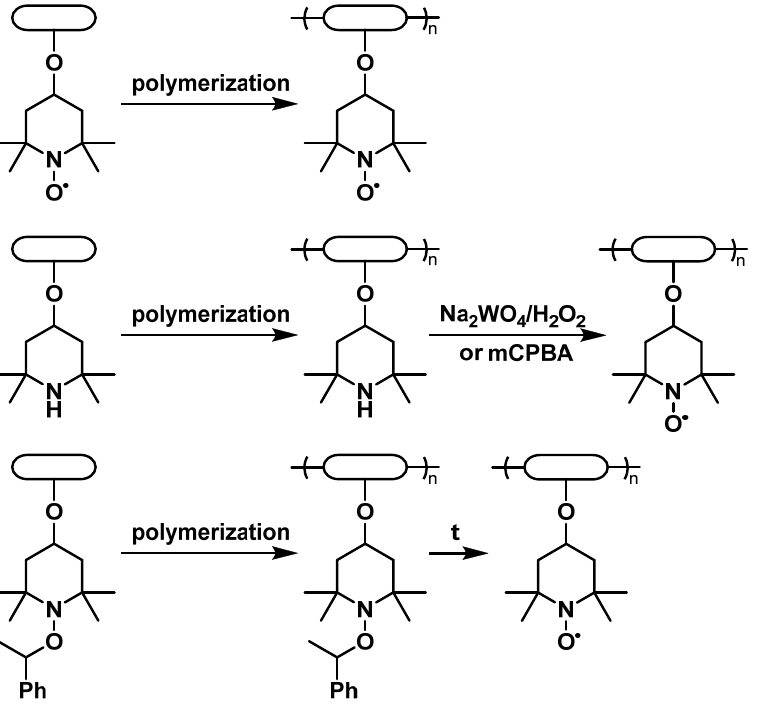
Figure 1. Polymerization of unprotected and protected TEMPO-containing monomers.